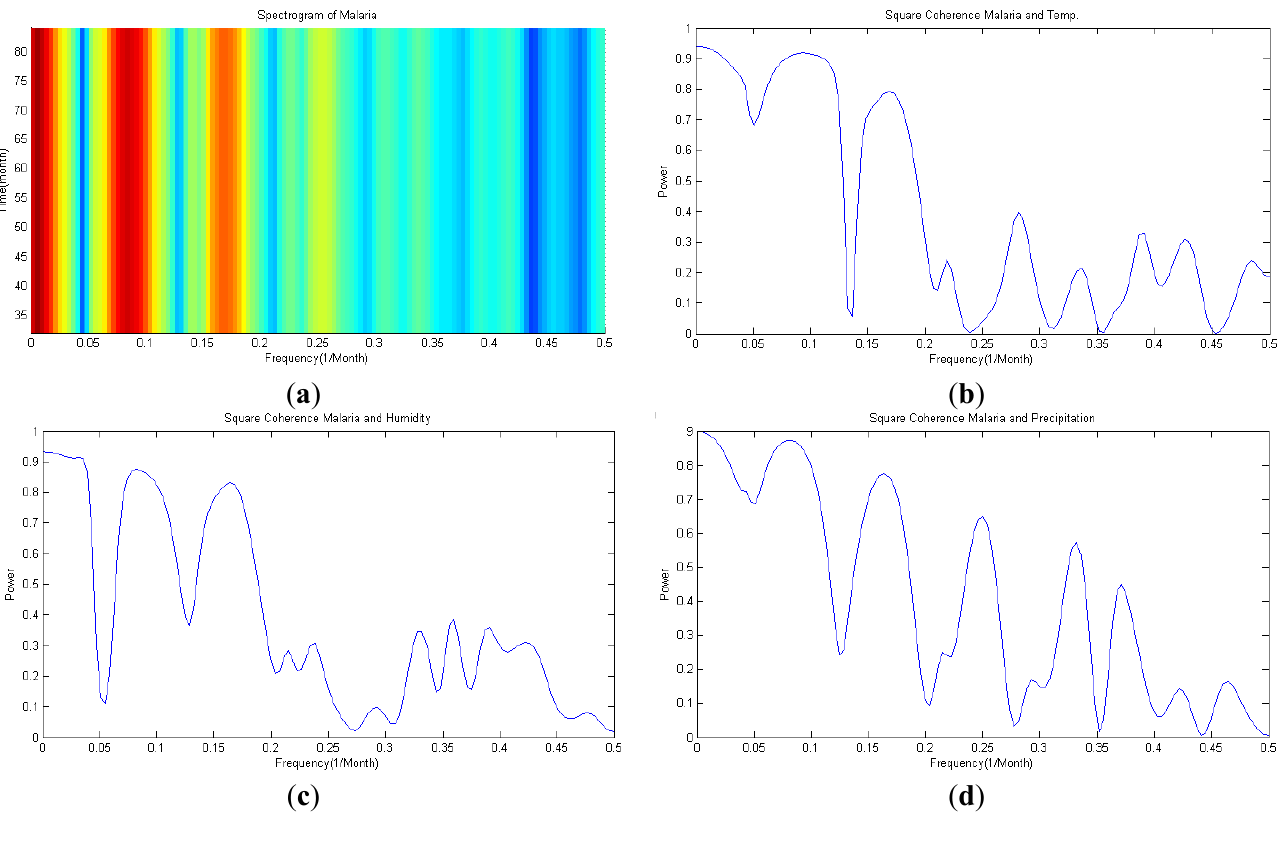
Figure 2. ( a ) Spectrogram of malaria; ( b ) coherency of Temp. and malaria; ( c ) coherency of humidity and malaria; ( d ) coherency of precipitation and